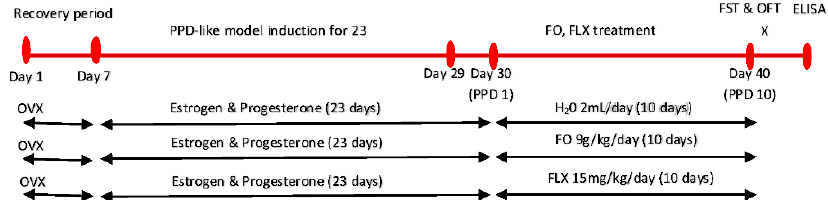
Figure 1. Experimental design for the protocol 1, evaluation of FO on PPD-like rat model. PPD— postpartum depression, FO—fish oil, FLX—fluoxetine, PCPA—p-chlorophenylalanine methyl ester, FST—forced swimming test, OFT—open field test, OVX—ovariectomy, H 2 O—water, X–euthanasia.